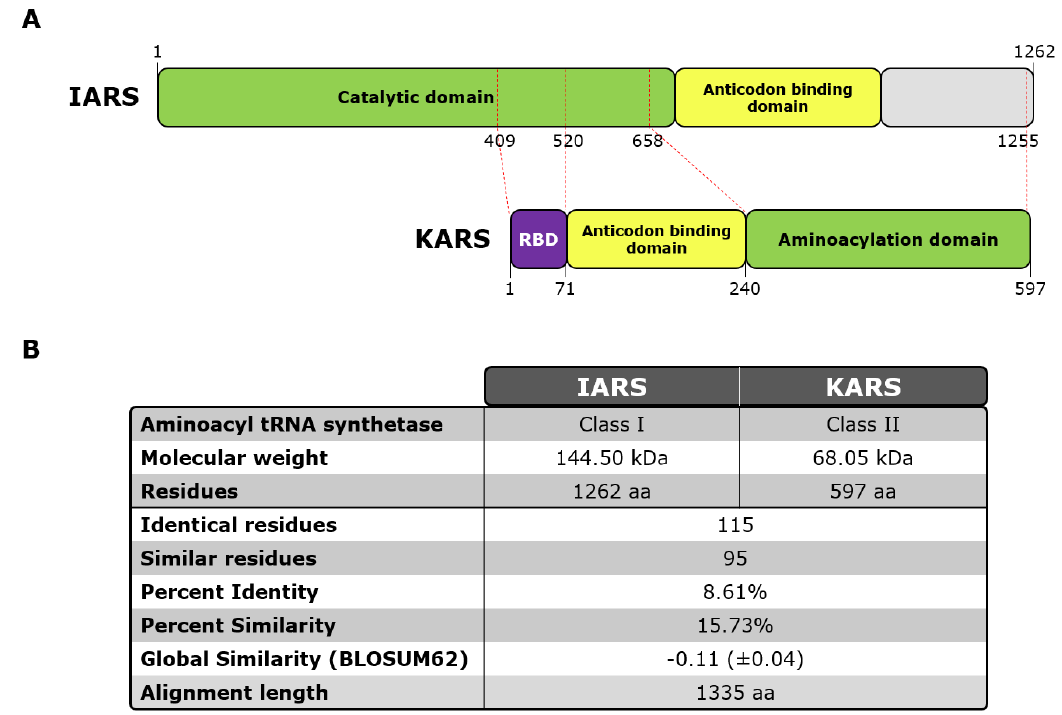
Figure 1. KARS and IARS protein scheme and sequence alignment overview . Legend: ( A ) Schematic view of human KARS and IARS proteins indicating functional domains reported in literature of each protein. Red dashed lines represent correlation (extracted from multiple sequence alignment) between KARS main domains and IARS amino acid sequence. (RBD: RNA Binding Domain). ( B ) Table containing protein sequence alignment of human KARS and IARS key features. Multiple alignment was carried out by Clustal Omega (RRID:SCR_001591). Abbreviations: aa, amino acids; kDa, kilodaltons; RBD, RNA binding domain.